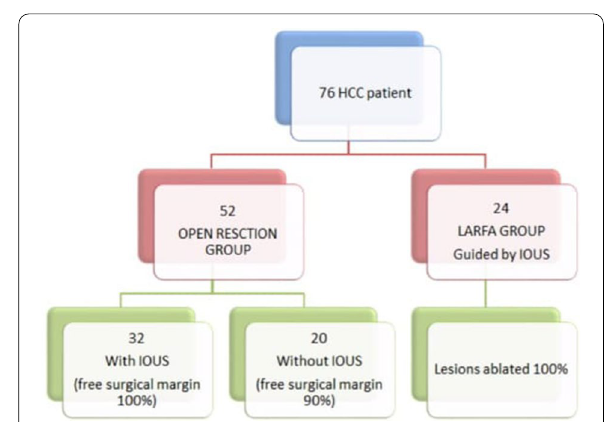
Fig. 1 Flowchart of the study